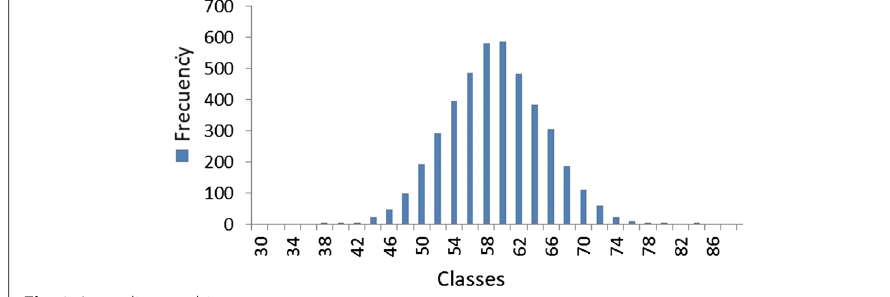
Fig. 9 Inter-distance